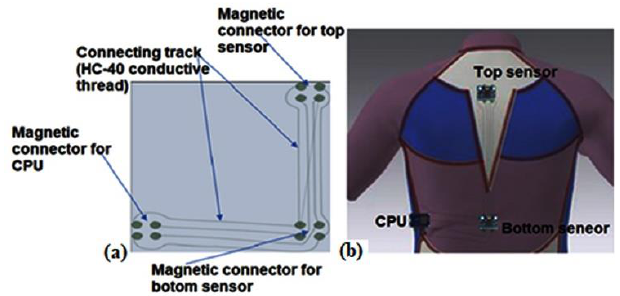
Figure 2. The e-textile interconnections line embroidered into the garment, with 4 encapsulated magnets per detachable module ( a ) and sensors attached on the t-shirt ( b ).